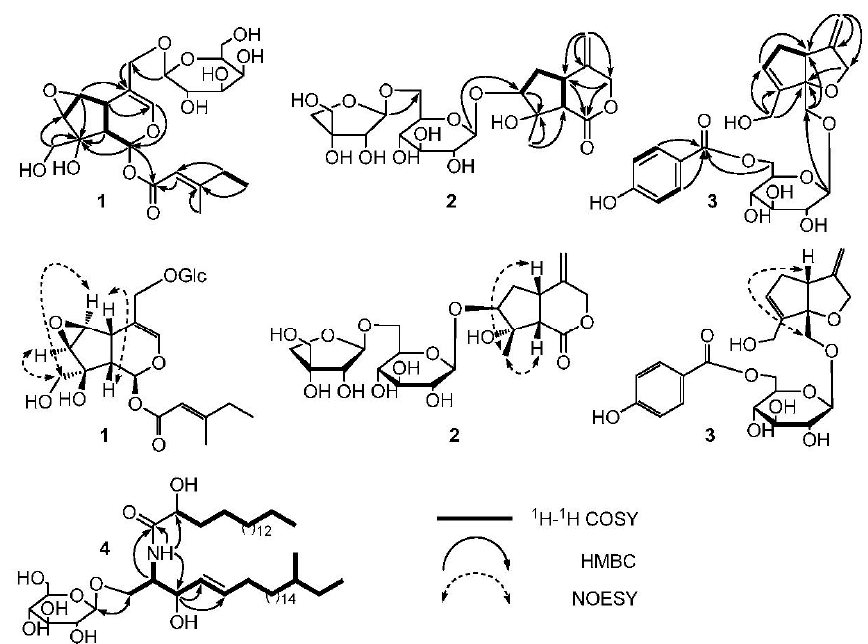
Figure 1. The 1 H − 1 H Correlation Spectroscopy (COSY), key Heteronuclear Multiple Bond Correlation (HMBC) correlations of 1 – 4 , and Nuclear Overhauser Effect (NOE) correlations of 1 – 3 .